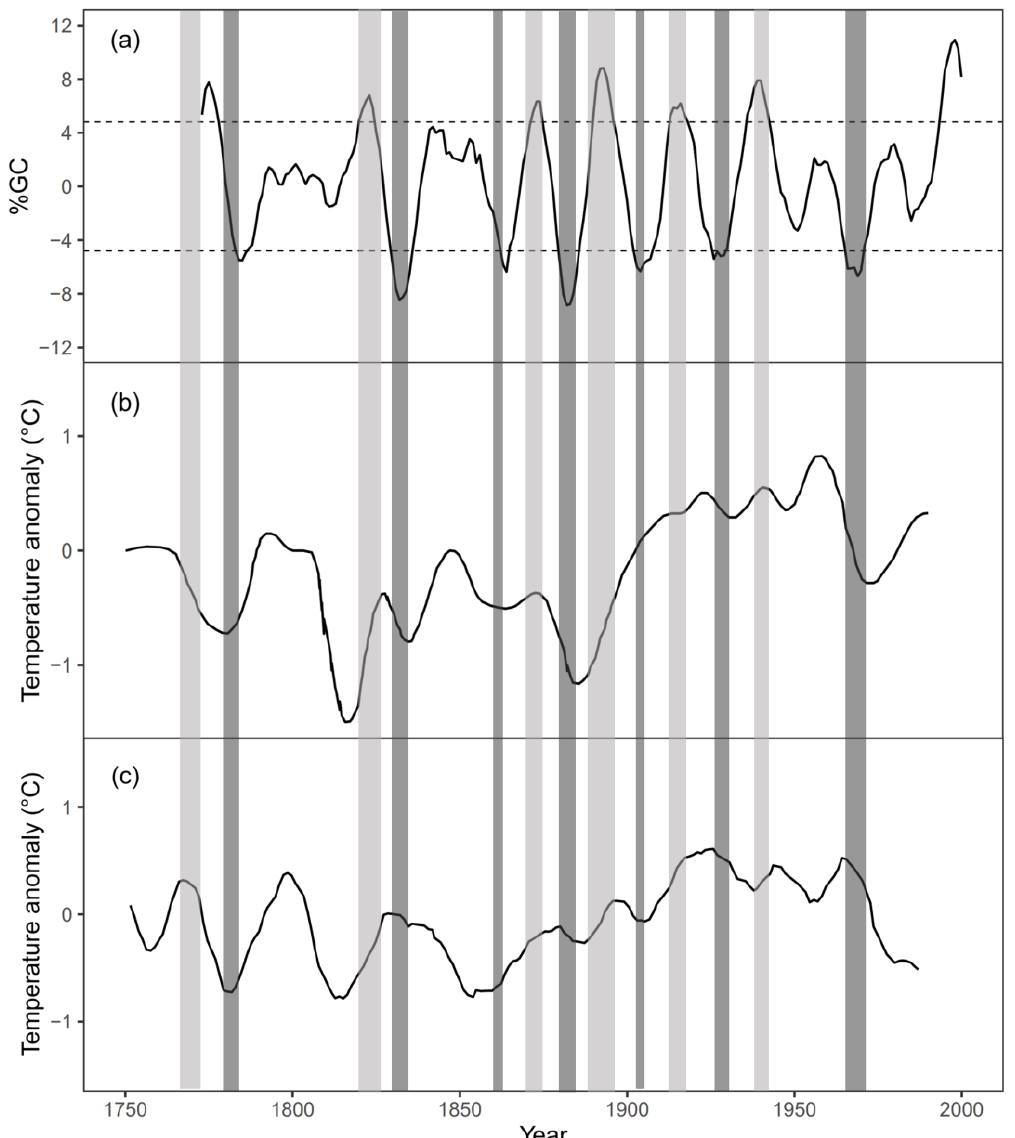
Figure 7. Comparison of ( a ) the regional %GC, ( b ) 10-year moving-average reconstructed summer temperature in the Northern Urals [41], and ( c ) 10-year moving-average reconstructed summer temperature in Siberia [42]. Light-grey and dark-grey shaded areas highlight the periods of positive and negative growth rate anomalies in this study matching the relatively warm and cool periods of those reconstructed temperatures.